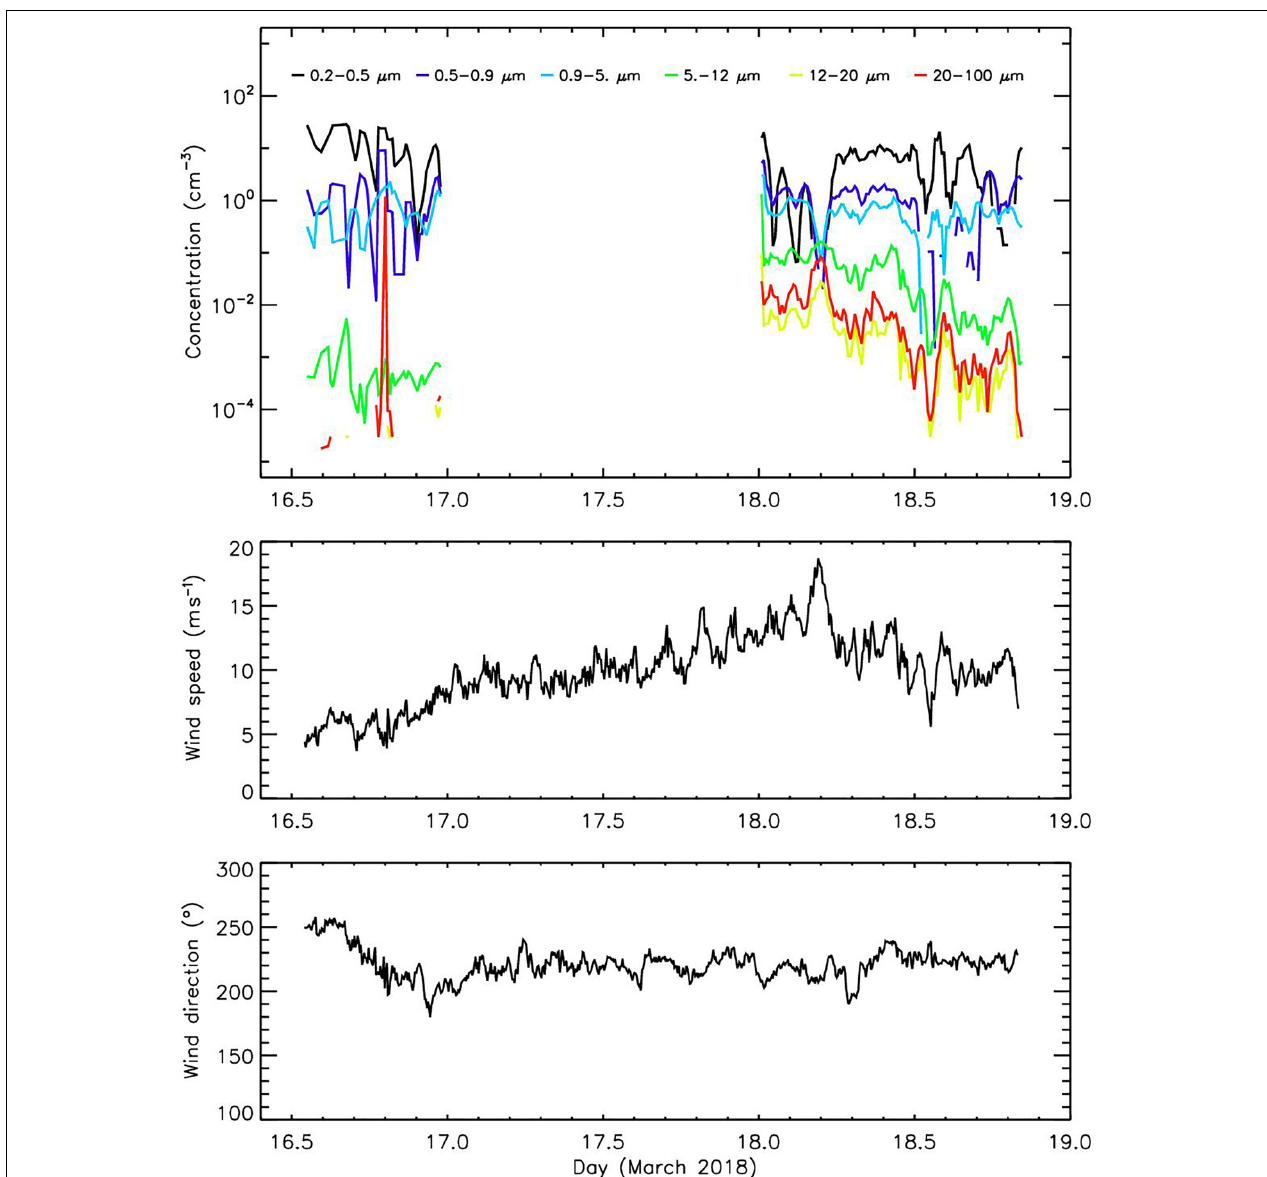
FIGURE 12 | Event 3 – wind conditions and aerosol